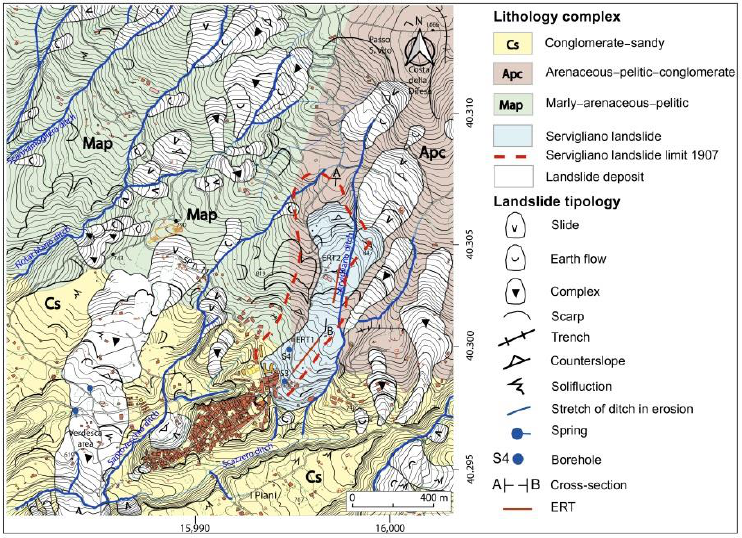
Figure 7. Landslide map of the study area.